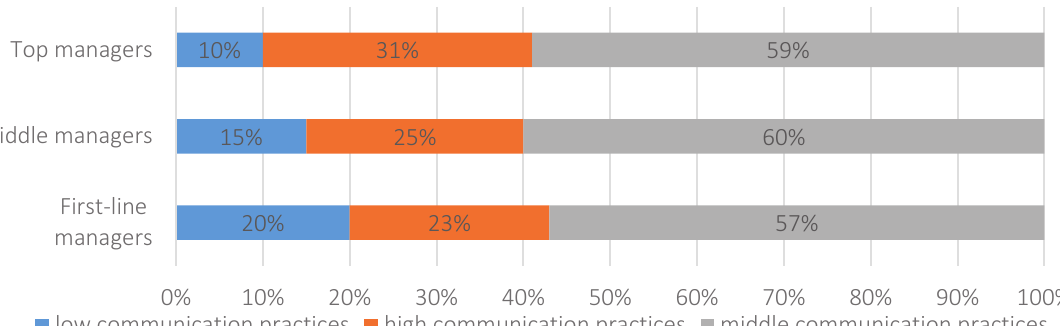
Figure 1. Distribution of managers within the levels of communication